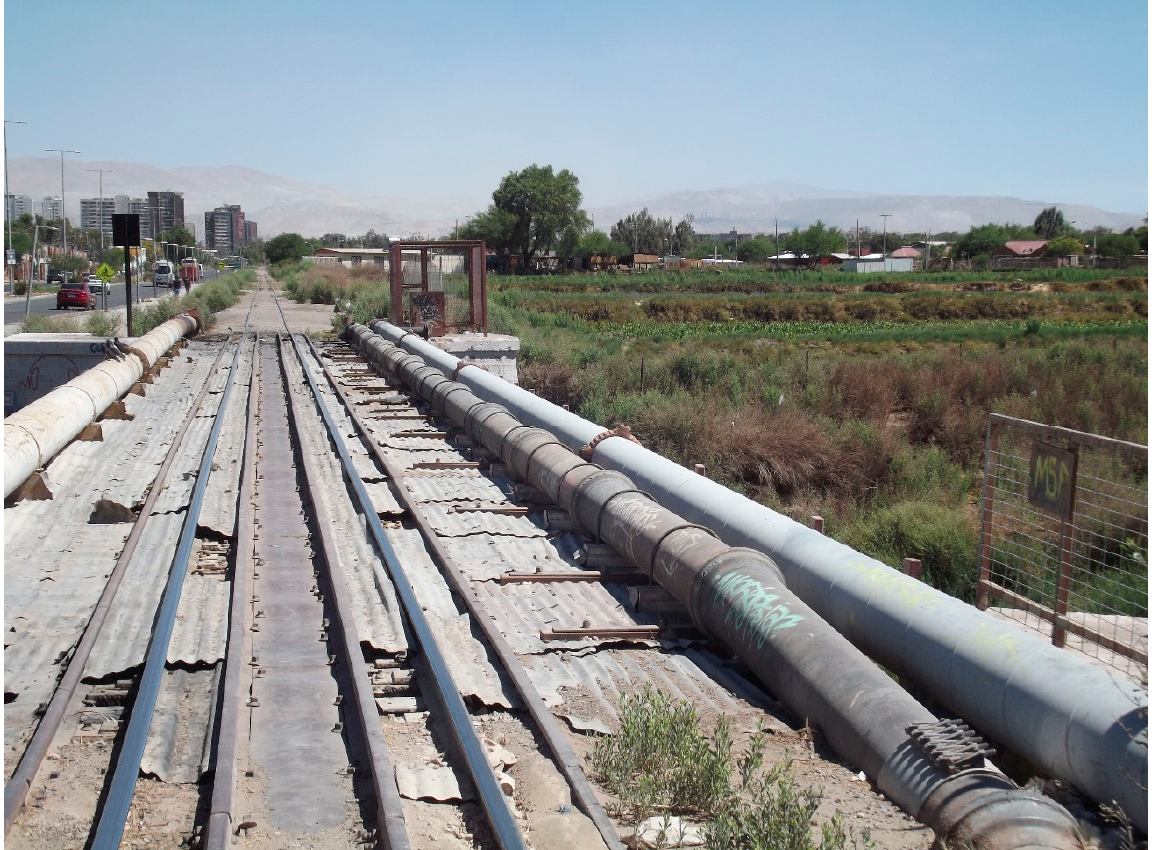
Figure 7. Agricultural lands adjoining urban lands in Calama in 2019. Source: the authors.